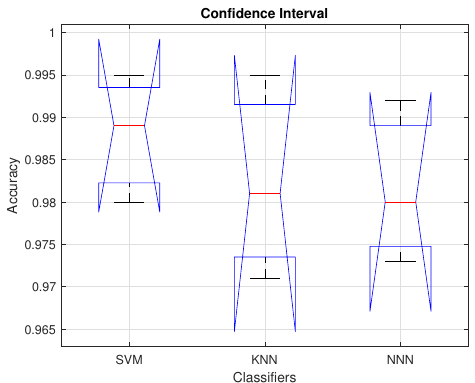
Figure 8. Confidence interval for selected